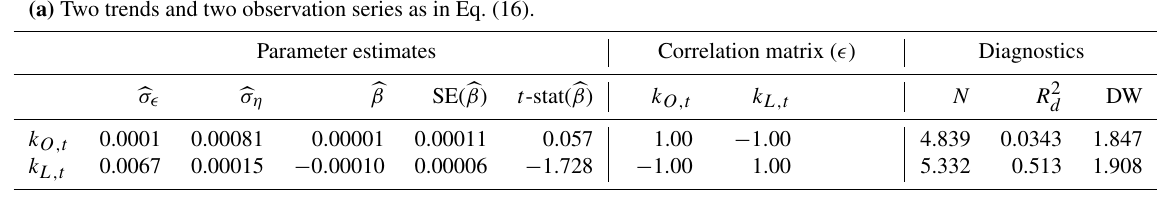
Table 5. Analysis of ocean and land sink rates. (a) Two trends and two observation series as in Eq.